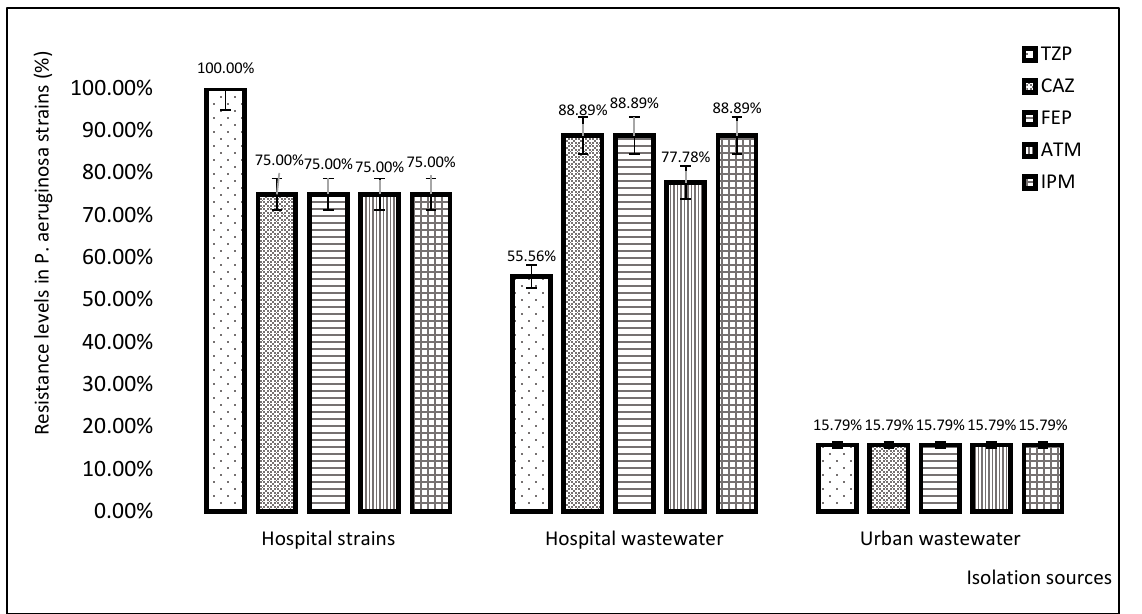
Figure 2. The antibiotic resistance levels (%) of P. aeruginosa strains depending on their isolation sources. Indeed, the molecular investigation of the genes encoding for antibiotic resistance revealed that the most frequently encountered encoding genes were for extended spec- trum β -lactamases (ESBLs), namely, bla CTX-M ( n = 30 strains), bla SHV ( n = 29 strains), bla GES ( n = 19 strains), and bla VEB ( n = 5 strains), followed by carbapenemase-encoding genes ( bla VIM , n = 3 strains) (Figure 3).